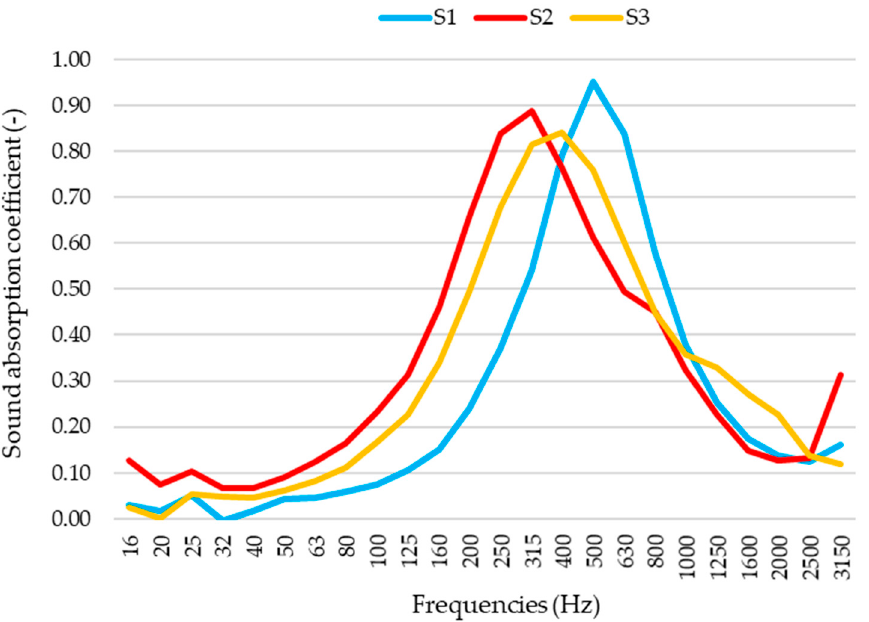
Figure 3. Sound absorption coefficient variation with perlite particle size (samples S 1 , S 2 , S 3 ).